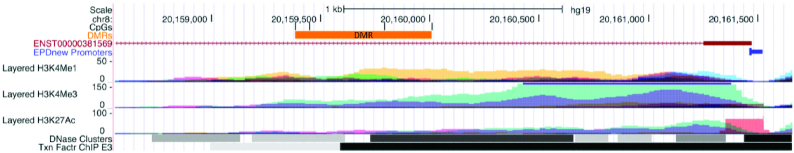
The LZTS1 differentially methylated region (DMR) within its genomic context and annotated with regulatory features (data tracks from the University of California, Santa Cruz genome browser). The identified DMR is intronic and downstream of a CpG island (green). The tracks show (in order): the chromosomal location; the CpGs making up the region; the LZTS1 DMR; Ensembl gene prediction (red); predicted promoter location (blue—Eukaryotic Promoter Database v006); histone tail marks H3K4Me1, H3K4Me3, and H3K27Ac indicating active regions of transcription (on 7 cell lines from ENCODE); DNAse hypersensitivity clusters showing open chromatin (125 cell types from ENCODE version 3); and transcription factor ChIP-seq clusters (ENCODE v3).